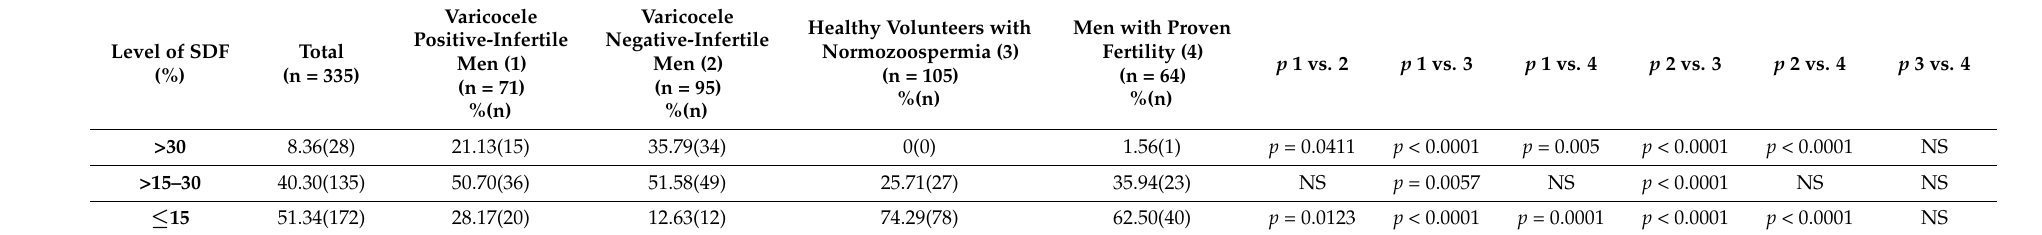
Table 2. Prevalence of SDF in study groups.